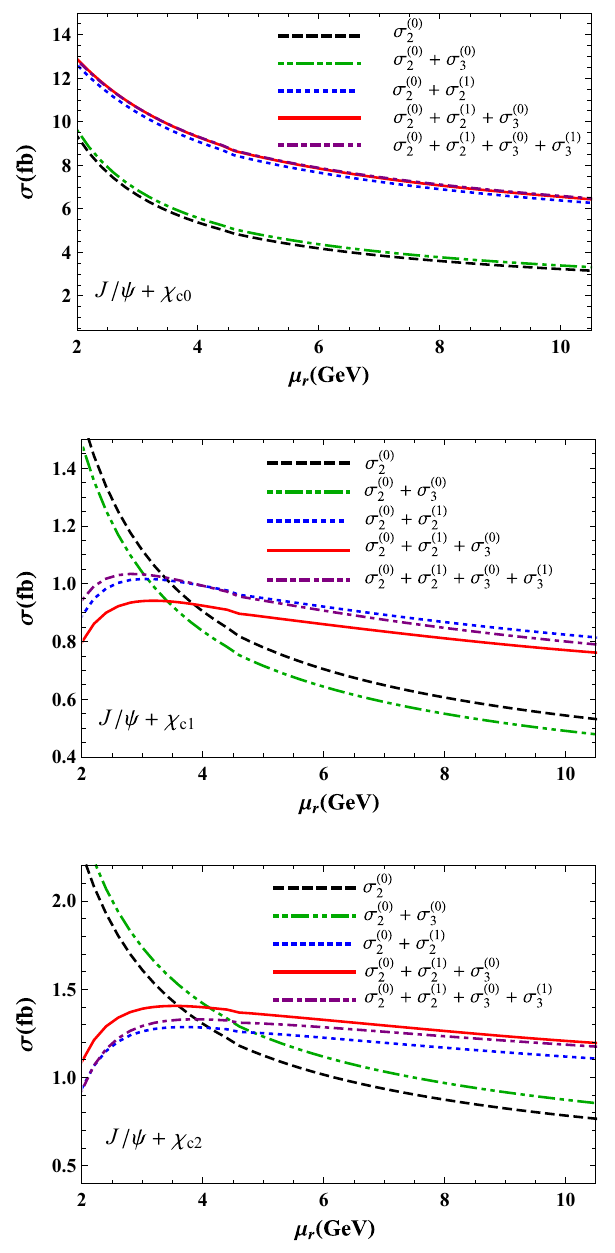
Fig. 3 Therenormalizationscaledependenceofthetotalcrosssections for e + e − → J /ψ + χ cJ ( J = 0 , 1 , 2) at GeV